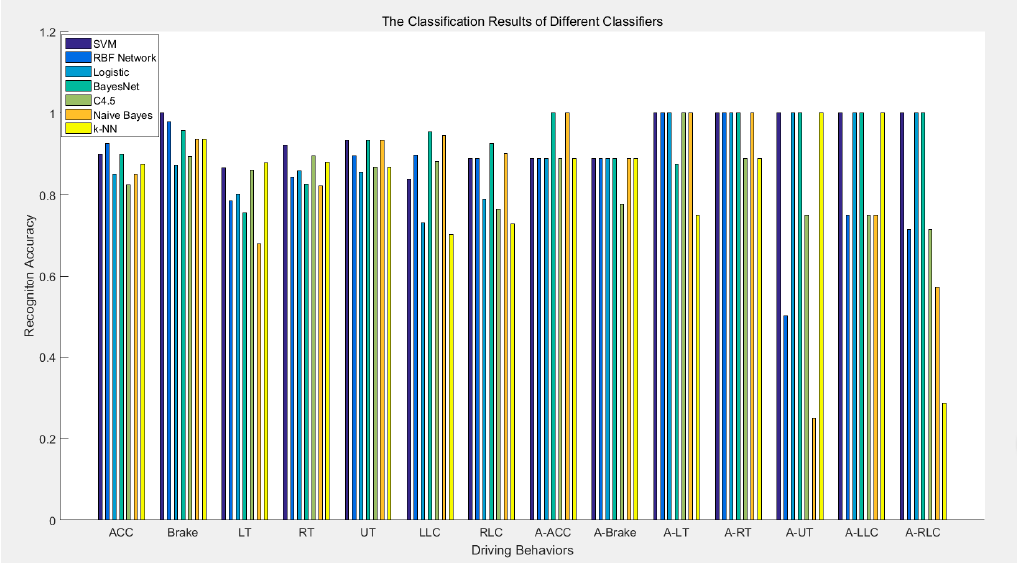
Figure 12. The performances of different classifiers. Table 6. The quantitative results of different